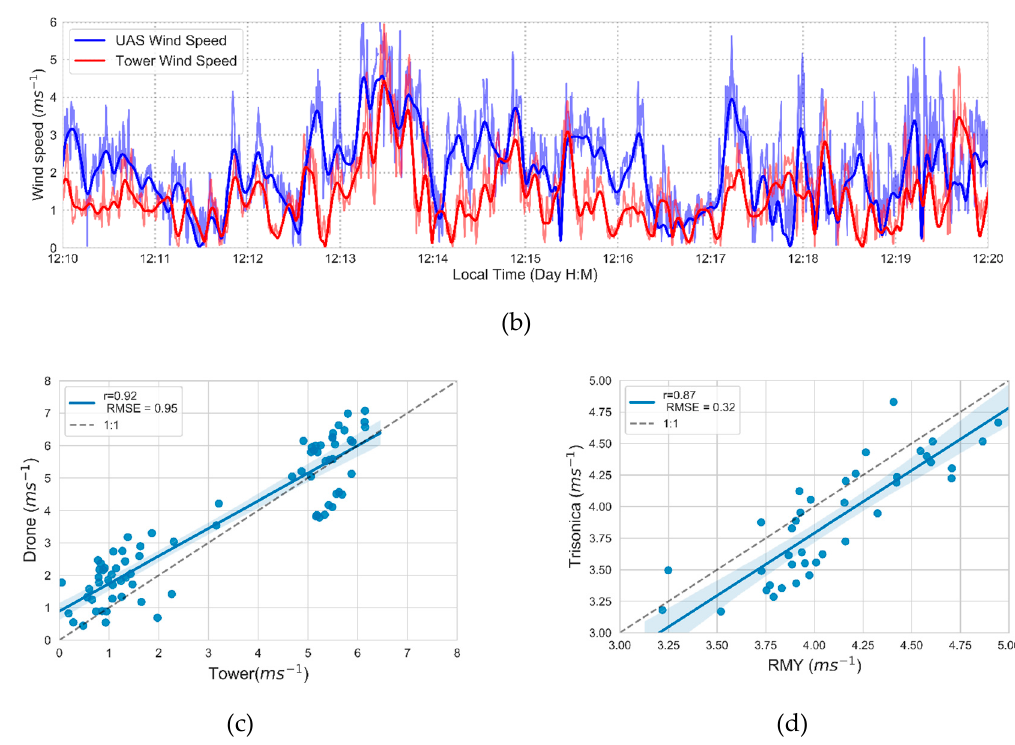
Figure 5. ( a ) Flight 1 time series of RMY and UAS wind speed in red and blue, respectively. Bold lines represent 15 s moving average with semi-transparent representing 1 s moving average. ( b ) Flight 2 time series of RMY and UAS wind speed in red and blue respectively with time averaging noted above. ( c ) Scatter plot of UAS wind speed versus RMY wind speeds for both flights in blue dots. Linear regression and 95% confidence interval in blue line and shading. ( d ) Scatter plot of tower-mounted Trisonica wind speed versus RMY wind speeds in blue dots. Linear regression and 95% confidence interval in blue line. Note: Scales on C and D differ so as to highlight ranges of data to emphasize bias.